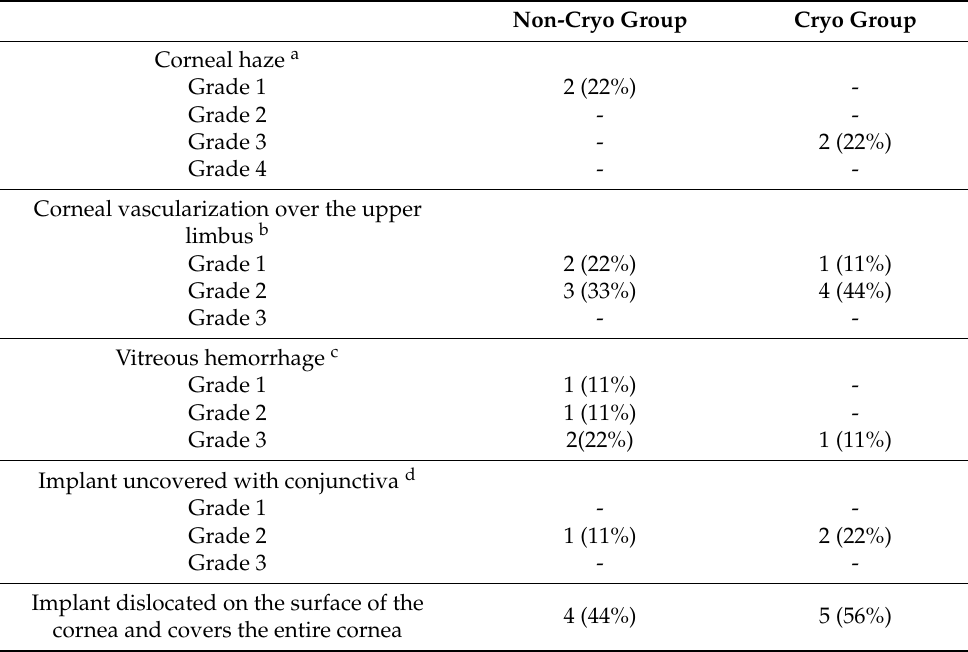
Table 2. Clinical grading of findings observed 14 days after implantation (the day of